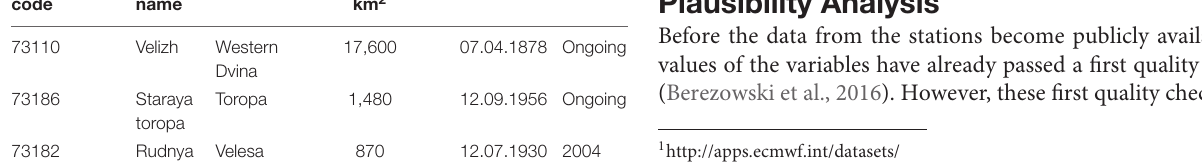
precipitations (RR), relative humidity (HU), wind speed (WND), and surface solar radiation downward (SSRD).